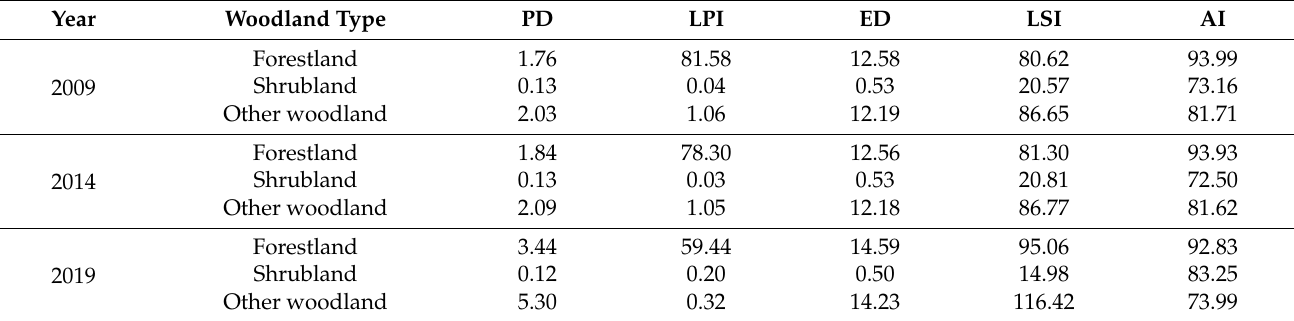
Table 7. Landscape pattern change in woodlands based on patch-level indices in Anyuan